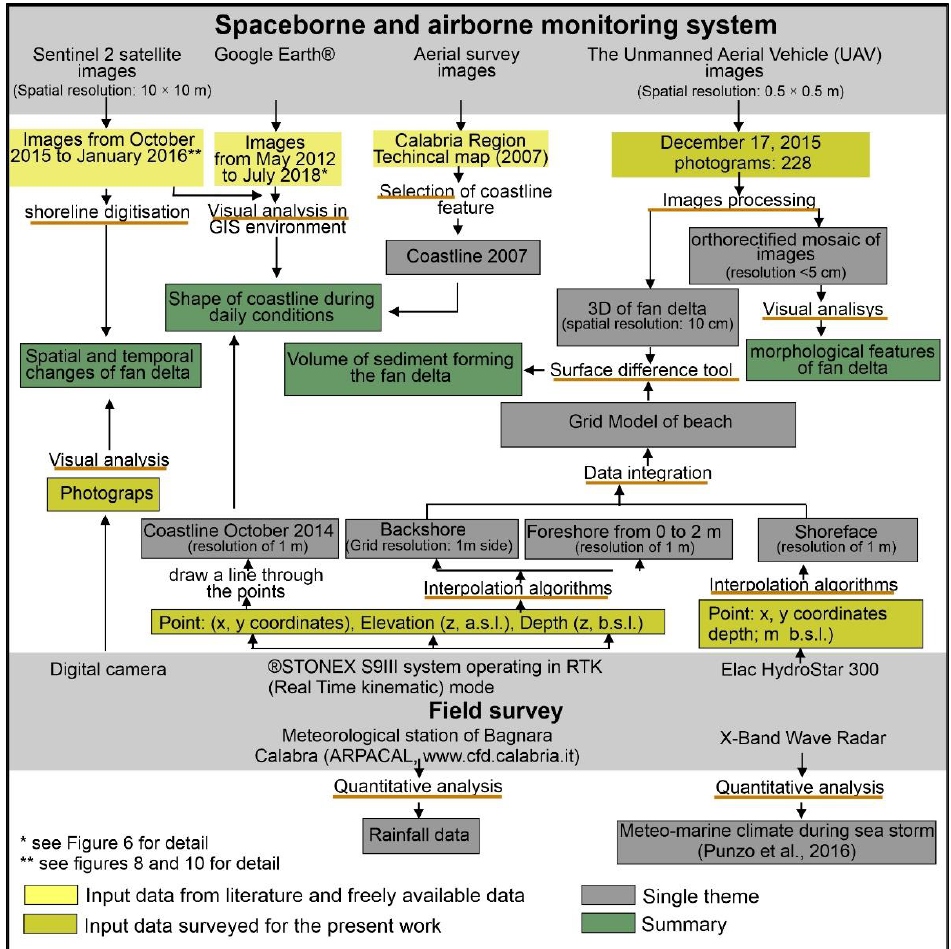
Figure 4. The flow chart illustrates the input data and procedure to study the formation and dismantling of the Sfalassà Stream fan delta. Source: own elaboration. The “x” and “xx” symbols indicate the figures showing the Google Earth and Sentinel 2 images, respectively.